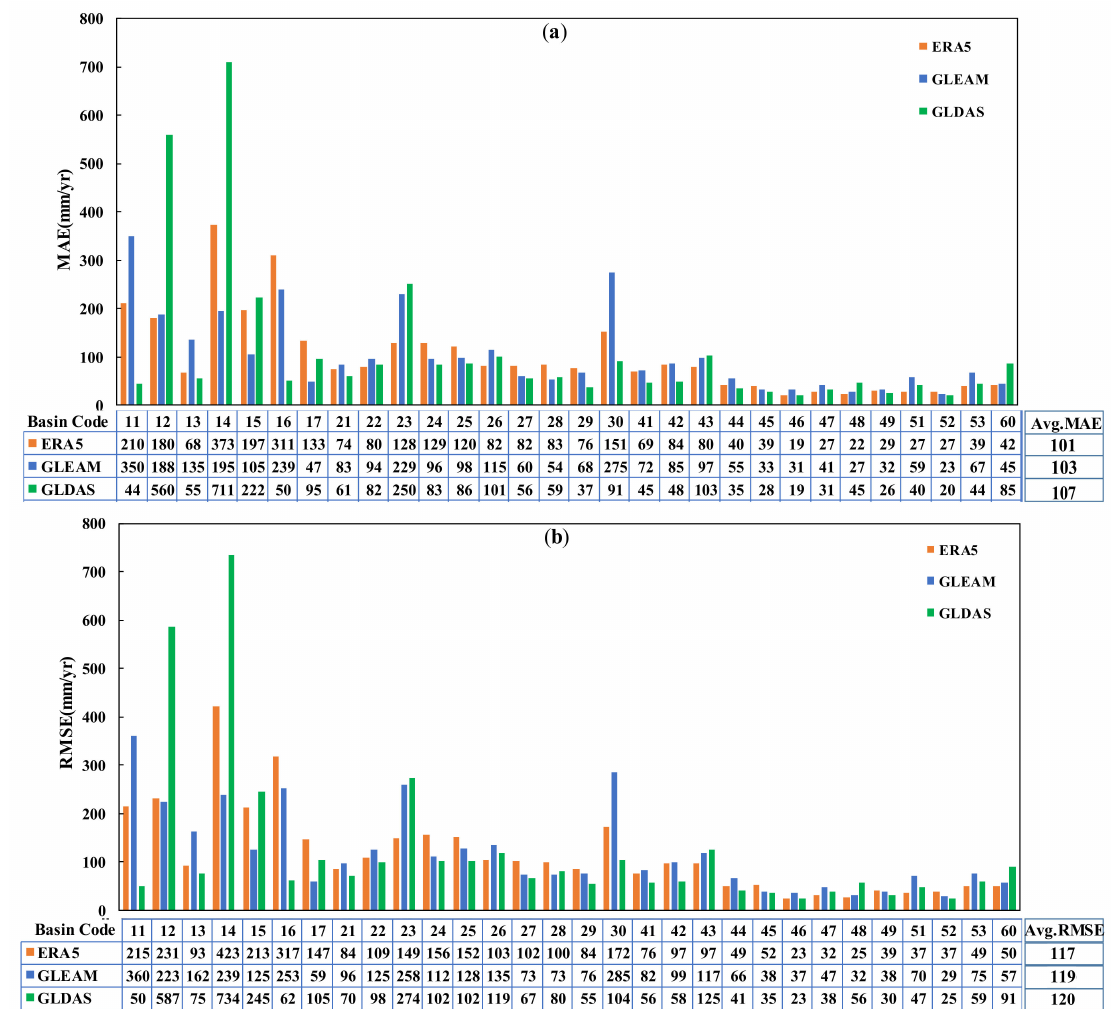
Figure 8. Error estimation of annual average ET ERA5 , ET GLEAM , and ET GLDAS comparing with ET WB . ( a ) Mean Absolute Error (MAE), and ( b ) Root Mean Square Error